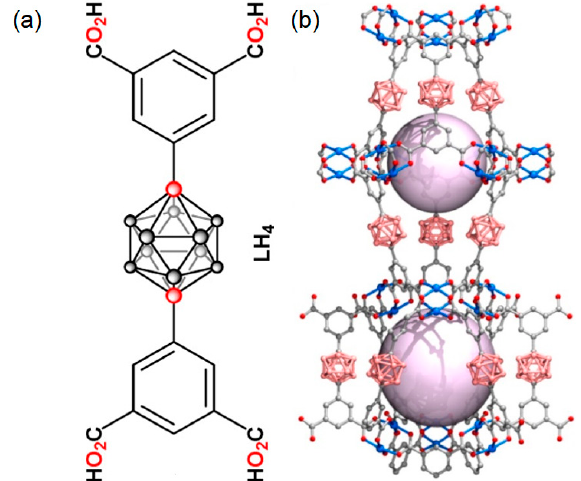
Figure 4. ( a ) Carborane–bis(isophthalic acid) ligand (LH4); ( b ) NU-135, which is a MOF which has a p -carborane subunit and Cu metal sites. Adapted with permission from Ref. [107]. Copyright 2013 American Chemical Society.